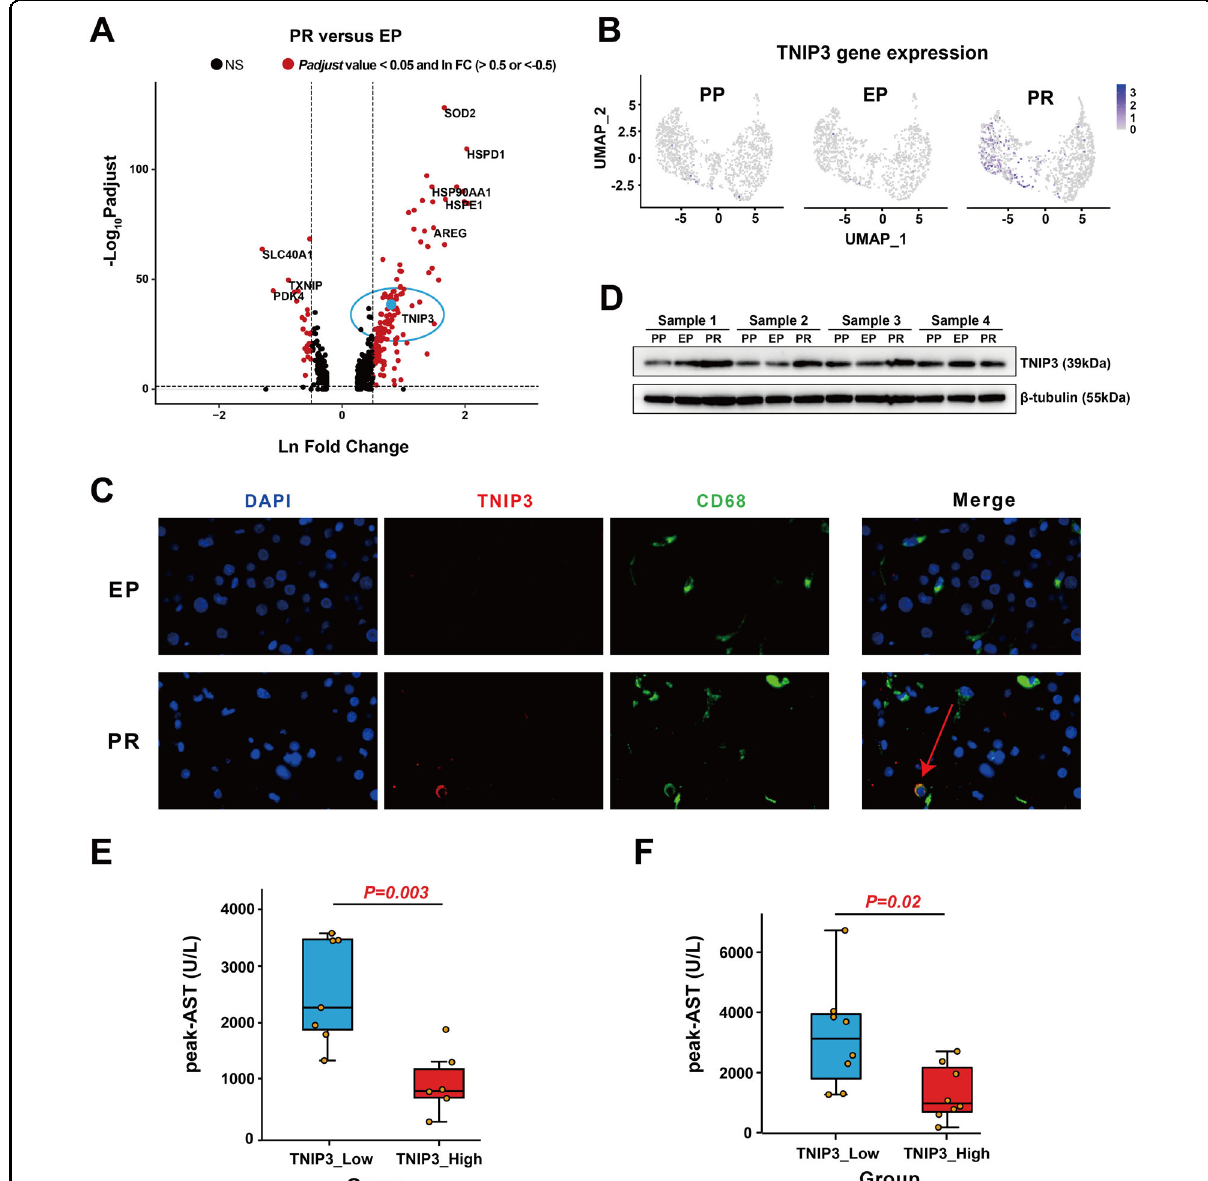
Fig. 3 TNIP3 expression is speci fi cally increased in KC clusters after IRI. A Volcano plot shows the DEGs of PR vs. EP in the C1QC_KC cluster. The red dots represent p adjust value less than 0.05 and lnFC greater than 0.5 or less than − 0.5, the blue dot represents TNIP3 , and the rest are black dots. B Feature plots showing the normalized expression of TNIP3 in mononuclear phagocyte clusters of PP, EP, and PR. Color represents the level of gene expression. C Immuno fl uorescence showed that the expression of TNIP3 (red), CD68 (green), and DAPI (purple) in EP and PR samples. CD68 + TNIP3 + cells only appeared in partly cells in the PR sample. D Western Blot results showed that the expression of TNIP3 in PR samples was higher than that in the EP and PP samples. E The postoperative peak-AST level in the TNIP3_low group was higher than the TNIP3_high group ( n = 13, 880 vs. 2506 U/L, p = 0.003) according to bulk RNA-seq data analysis results, each point represents a patient. F The postoperative peak-AST level in the TNIP3_low group was higher than the TNIP3_high group ( n = 16, 1316 vs. 3216 U/L, p = 0.02) according to the RT-PCR results of 16 pairs of liver